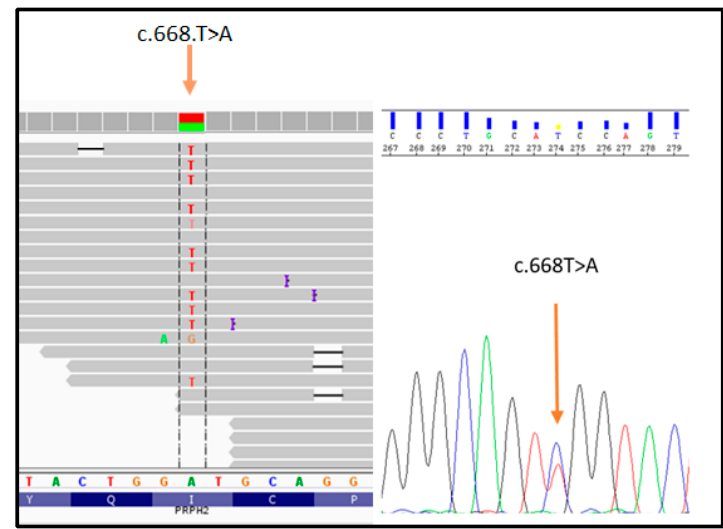
Figure 2. Illustration of the PRPH2 _c.668T > A variant detected by NGS (on the left) and subsequent confirmation by direct sequencing (on the right).